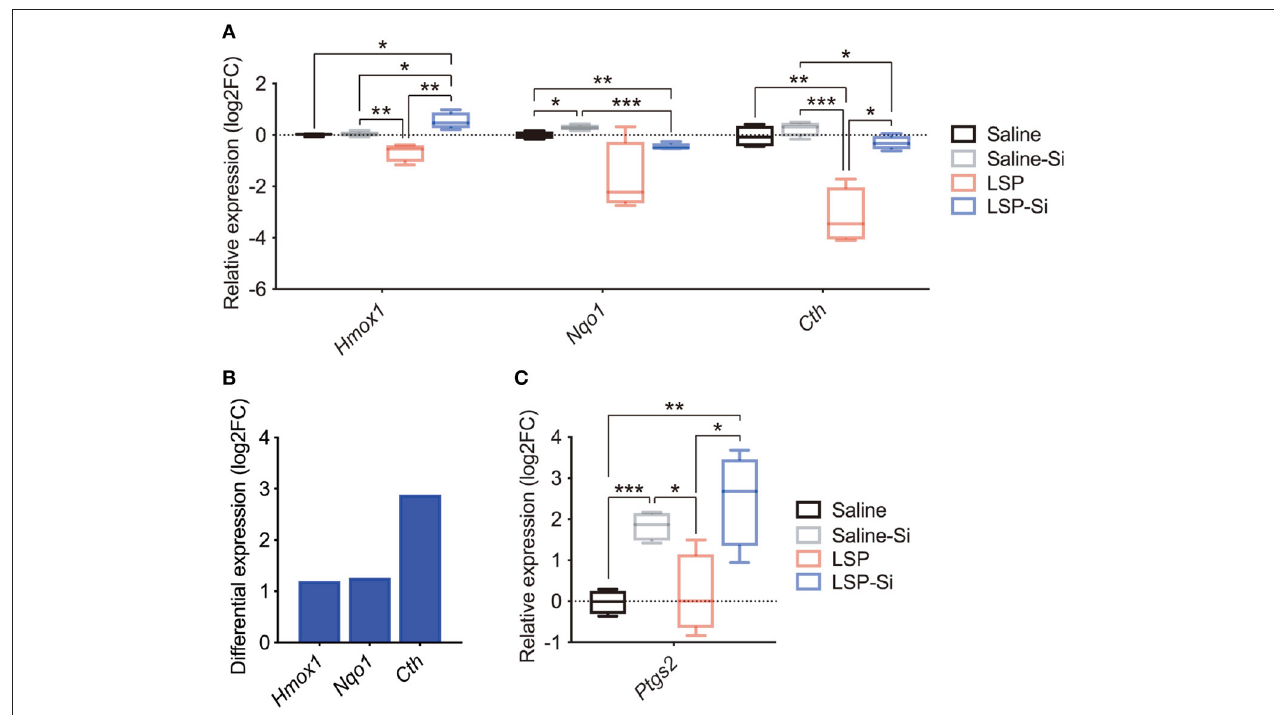
FIGURE 4 | Expression levels of antioxidant and antiapoptotic genes after treatment with the Si-based agent. (A) Relative expression levels of antioxidant genes ( Hmox1 , Nqo1 , and Cth ) in the whole mouse placenta at 4h after the second administration. Hmox1 expression was significantly elevated in the placenta of LPS-treated mice administered the Si-based agent. (B) Differential expression analysis of the effect of Si-based agent in LPS-treated mice. (C) Relative expression levels of the antiapoptotic gene Ptgs2 in the mouse placenta at 4h after the second administration. Significant increases in the expression of Ptgs2 were observed in the placentas of Si-based agent-treated mice and LPS-treated mice administered the Si-based agent. Data are presented as means ( ± SEM). Asterisks indicate *** P < 0.001, ** P < 0.01, * P < 0.05, unpaired t -test or Mann–Whitney U -test. n =